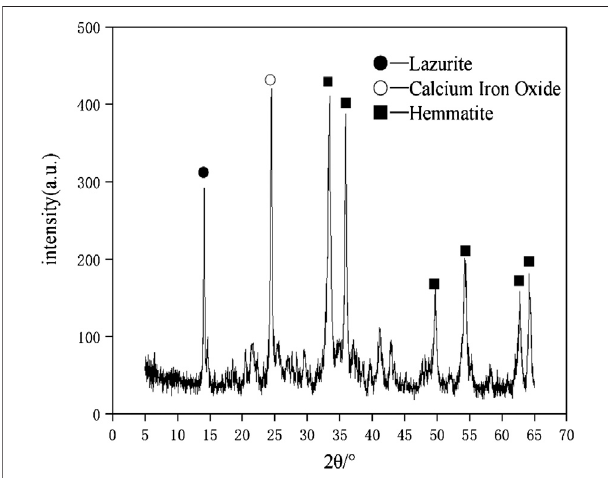
FIGURE 3 | XRD diffractogram of fl y